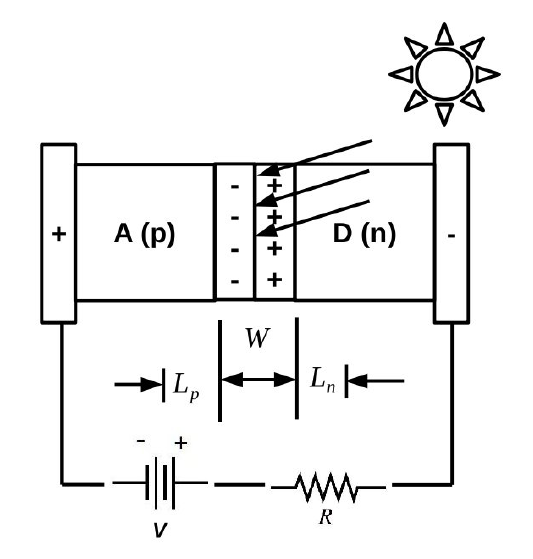
Figure A1. Schematic of an organic solar cell as a Shockley